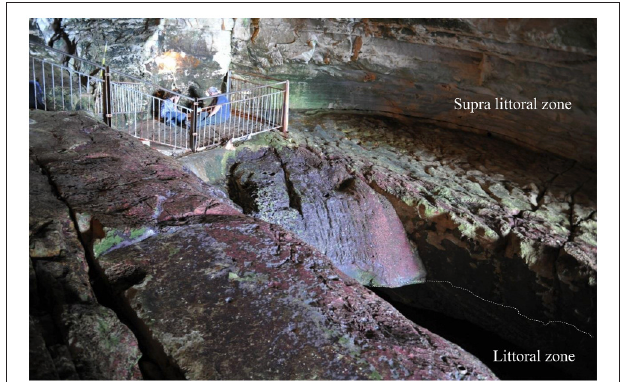
FIGURE 1 | Colorful epilithic algae in the supralittoral zone of the littoral cave system of Rosh